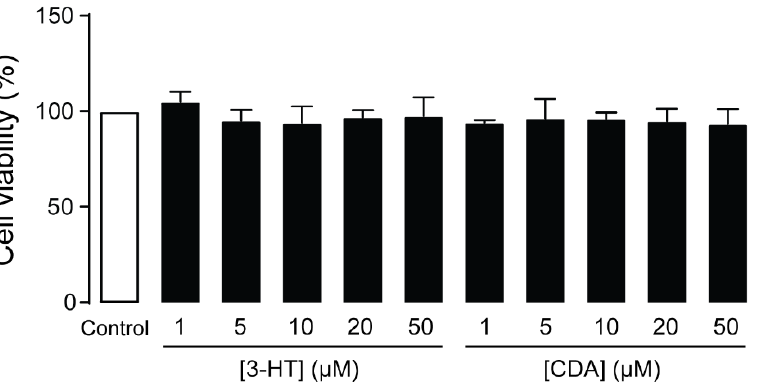
Figure 3. Cytotoxic evaluation of 3-hydroxyterphenyllin (3-HT) and candidusin A (CDA). Podocytes were grown on 96-well plates for 24 h with vehicle (control) or 3-HT or CDA at the indicated concentration before performing the MTT assay. The data are expressed as percent cell viability of control ( n = 3). There was no significant difference between the control and treatment